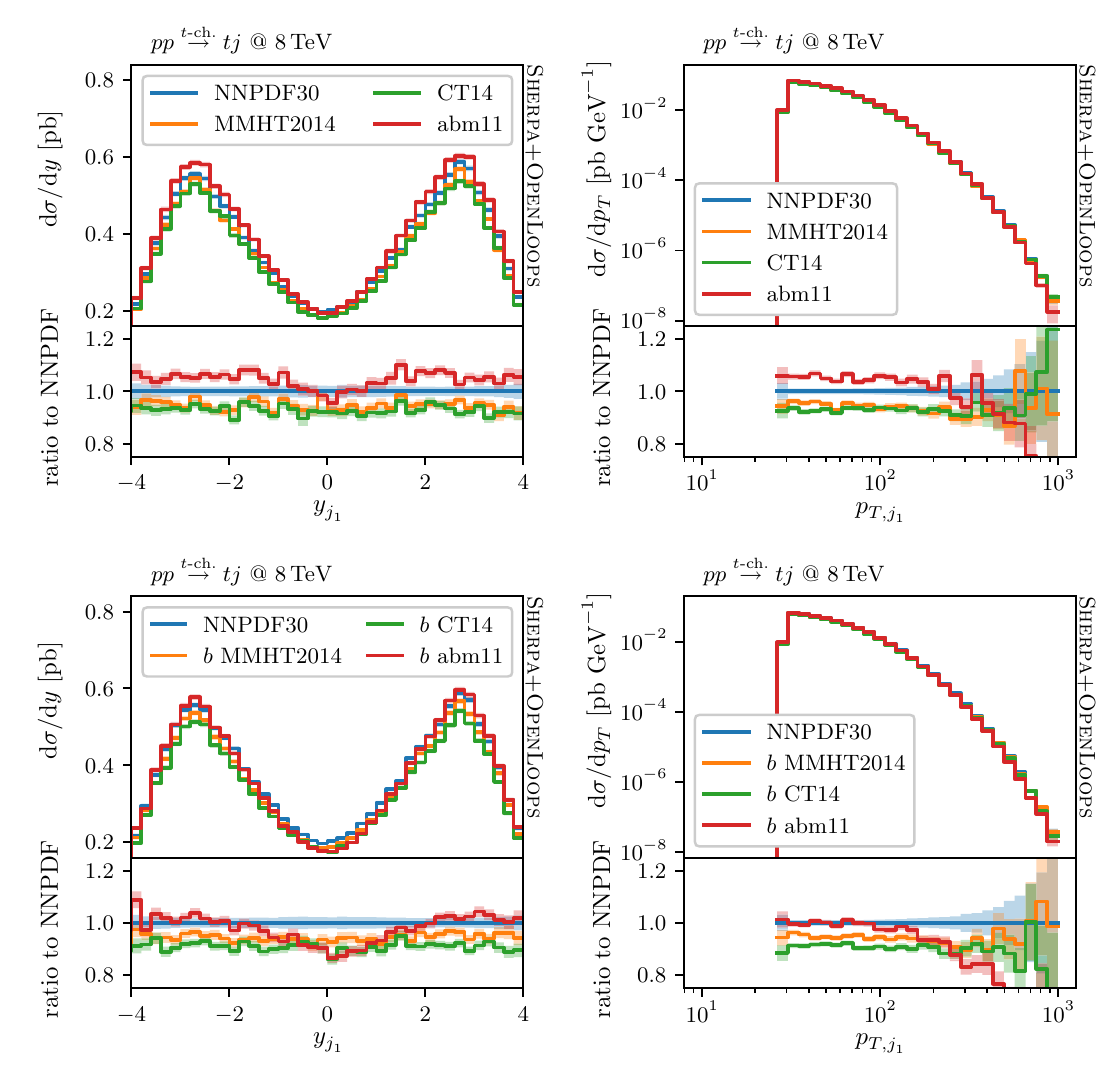
Fig. 4 The impact of different PDF sets on the leading-jet rapidity (left column) and transverse momentum (right column) in M C @N LO t - channelsingle-topproductionwithinthefiducialphase-spaceasdefined